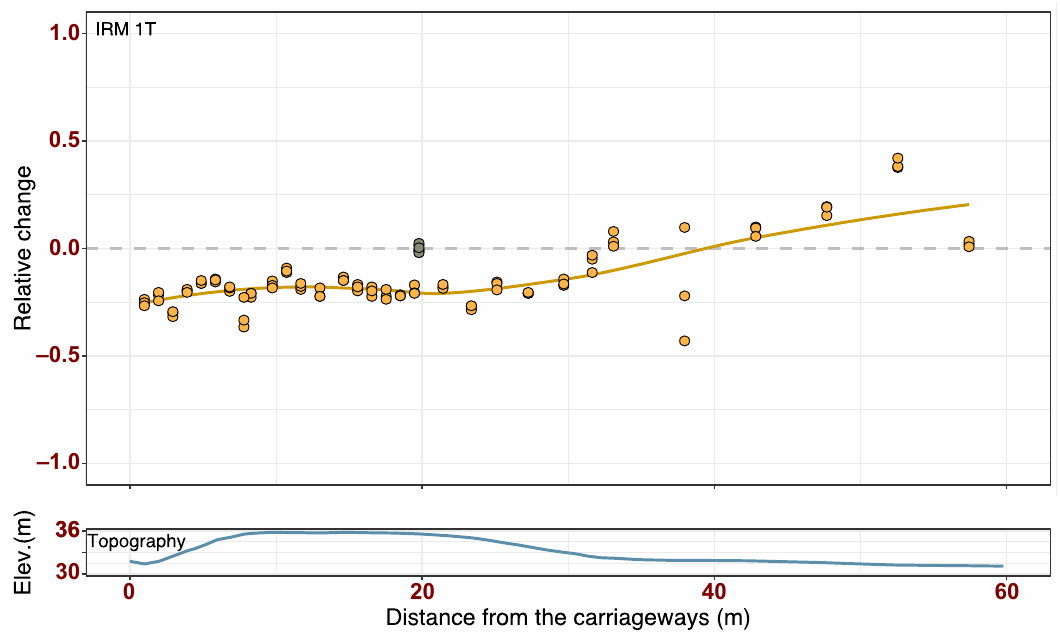
Figure 6. Relative changes from surface soil samples (yellow closed circles) along the transect shown on Figure 1. RC are calculated with a reference sample (gray circles) taken at 1-m depth with an auger from the top of the berm.